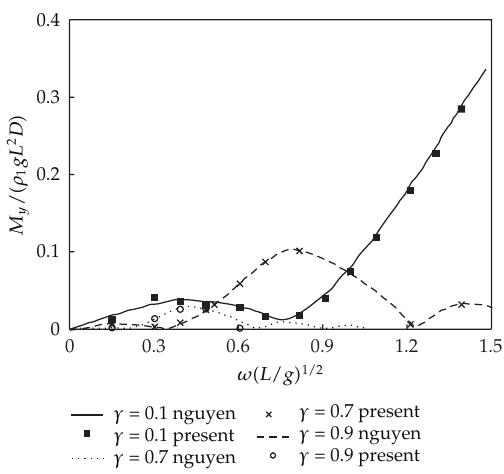
Figure 11: Pitch moment on